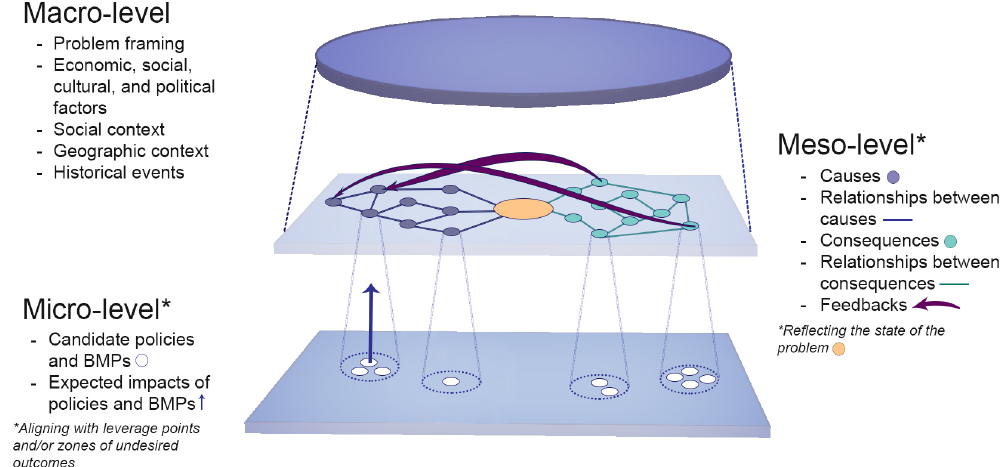
Figure 1. Components of storylines at three levels: Macro-level, Meso-level, and Micro-level (modified from Geels et al. (2002) to accom- modate multi-level storyline development).